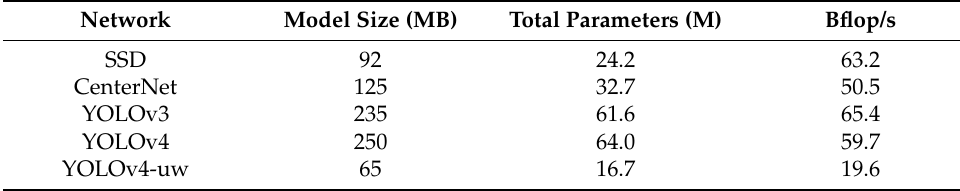
Table 4. Comparison between YOLOv4-uw and other one-step